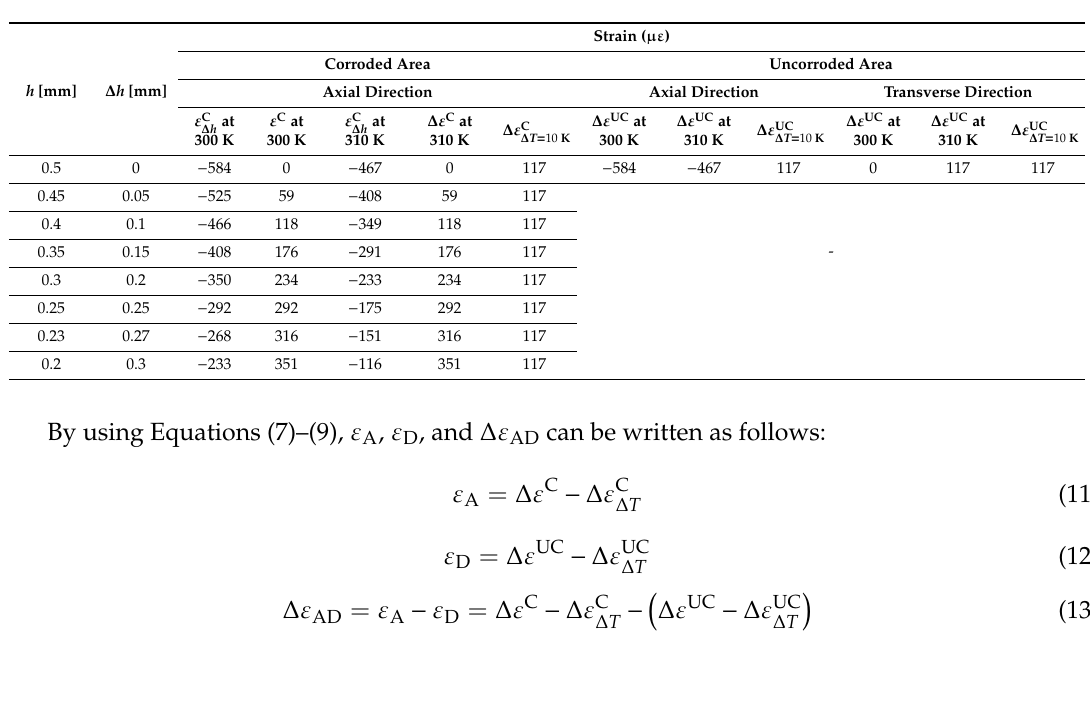
Table 1. Strains obtained from FEM